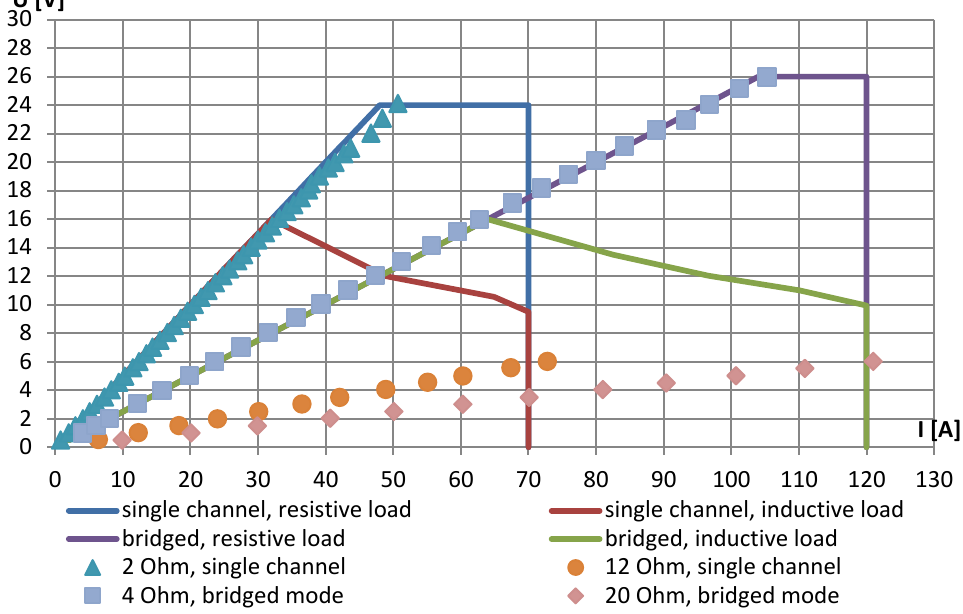
Figure 6. The rms values of the output current vs. output voltage of the audio power amplifier for separate resistive and inductive loads for single channel operation and in bridged mode.